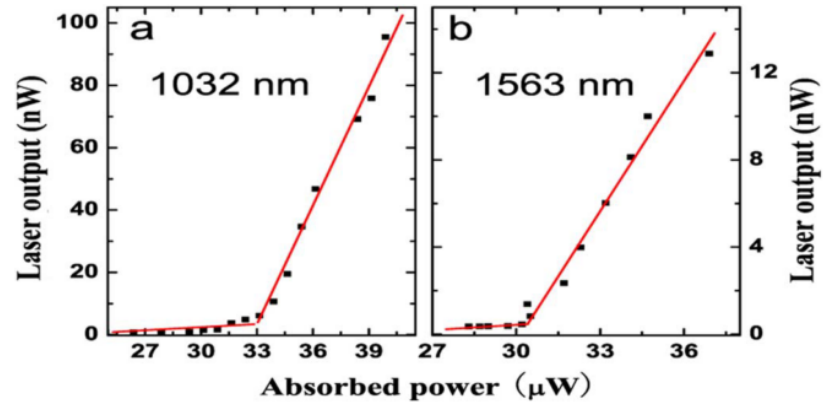
Figure 10. (a) Relationship between absorbed power and laser output, the lasing wavelength is 1032 nm; ( b ) the lasing wavelength is 1563 nm. Reprinted/Adapted with permission from [31].